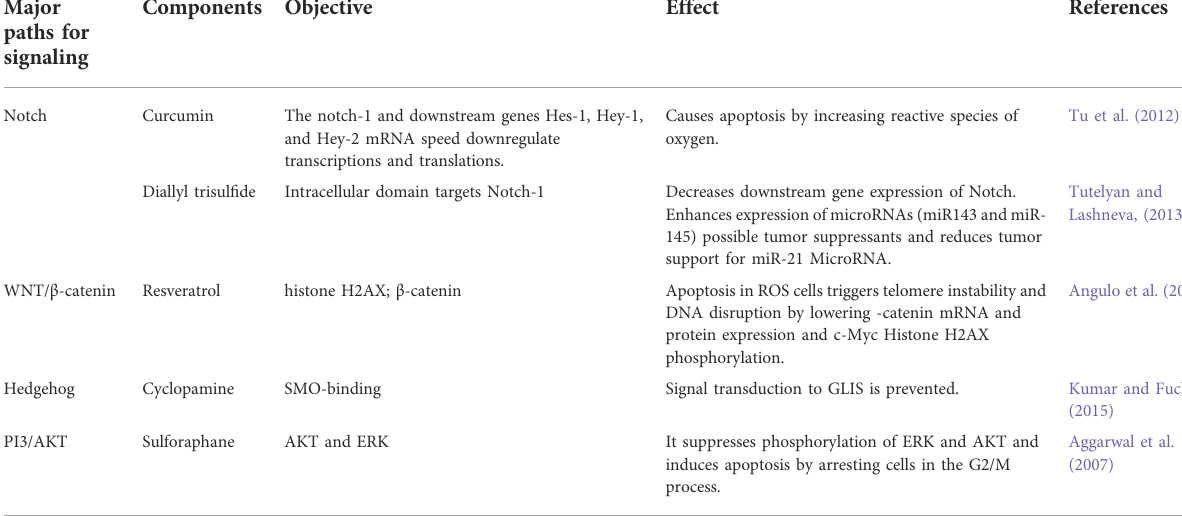
TABLE 2 Impact of natural compounds affecting signi fi cant stem pathways cell signaling (Angulo et al.,